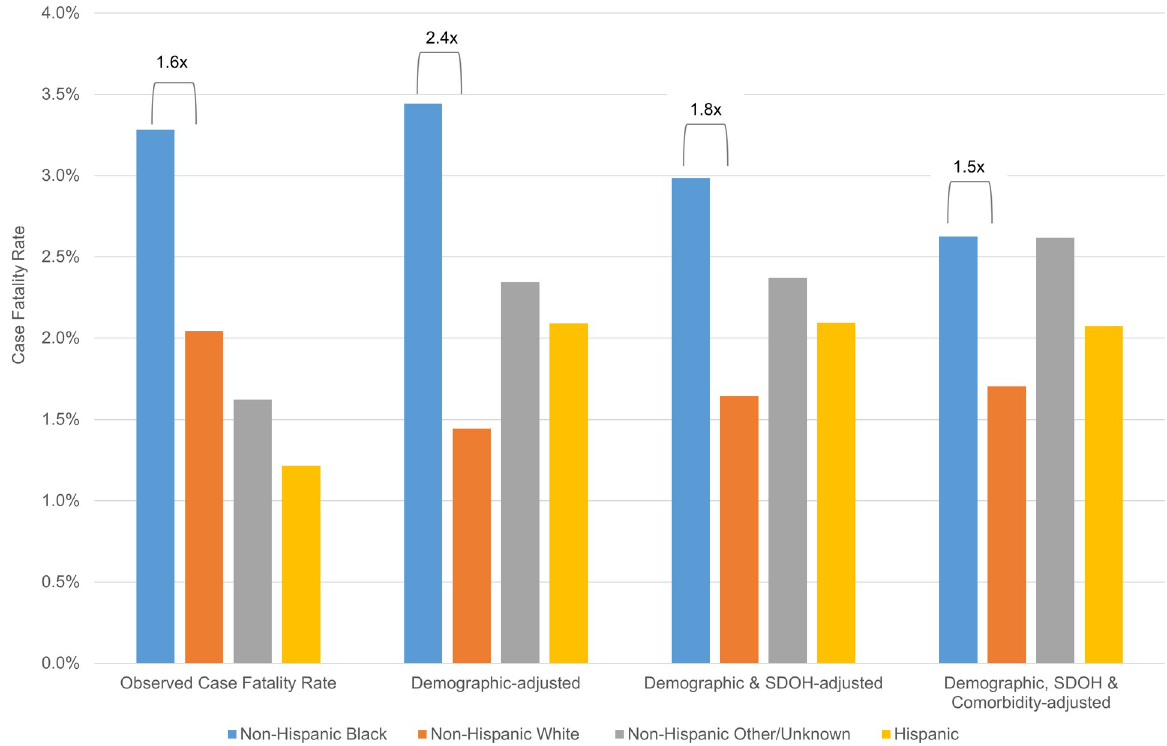
Fig 3. Observed and risk-adjusted case fatality rates. Abbreviations: SDOH, social determinants of health. Brackets depict ratio of case fatality rate for the group of interest versus White patients, using the random effects model described in the methods.